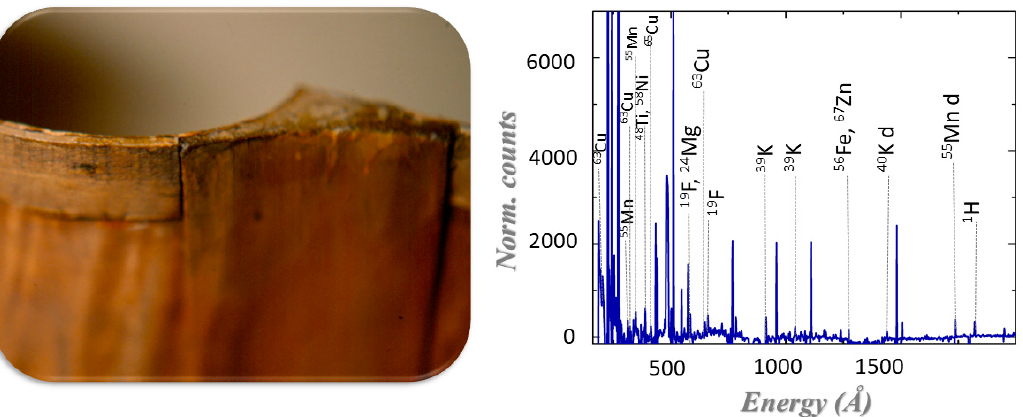
Figure 4. Prompt gamma activation analysis (PGAA) ( Right ) of a wooden sample that has been treated with surface coatings ( Left ).